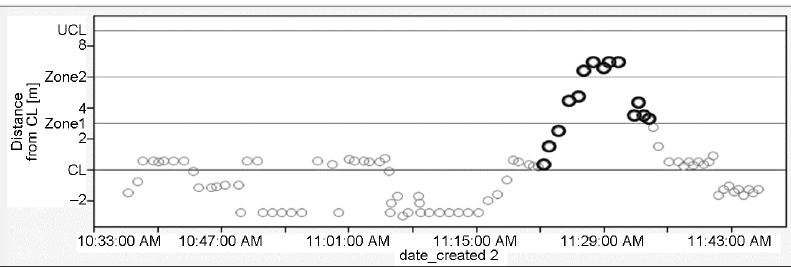
Fig. 3. A statistical alert of a worker approaching the